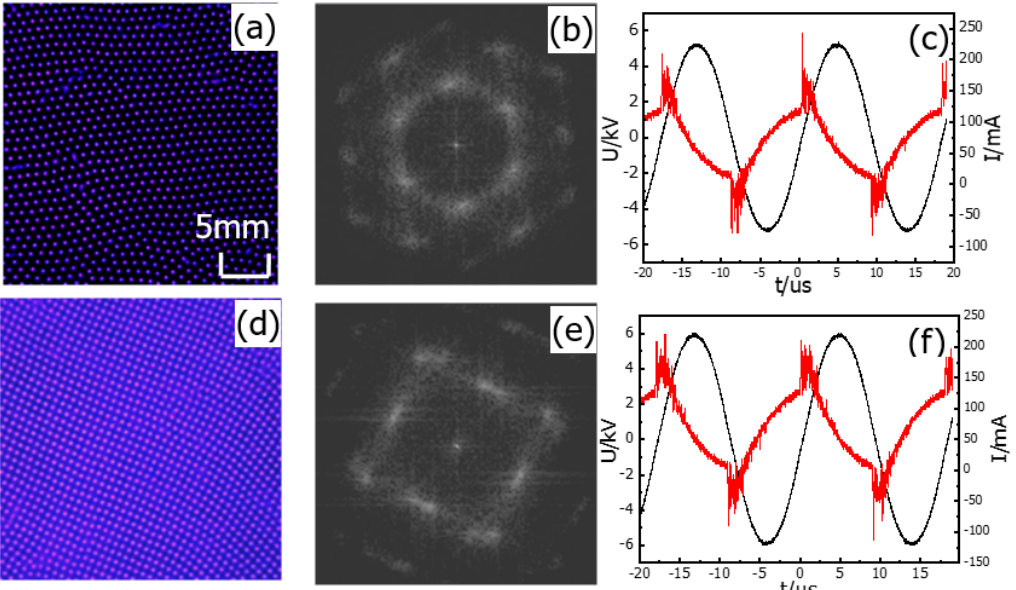
Figure 2. Plasma photonic crystals with different symmetries when increasing of the applied voltage. The left column: snapshots of the triangular plasma photonic crystal ( a ) and square plasma photonic crystal ( d ). The middle column: the corresponding Fourier spectra of triangular lattice ( b ) and square lattice ( e ). Right column: the voltage-current waveforms associated with the triangular lattice ( c ) and square lattice ( f ). The discharge parameters are: ( a ) the applied voltage U = 5.3 kV, discharge power p = 32 W ( d ) U = 6.0 kV, p = 46 W. The frequency of the applied voltage f = 55 kHz. The working gas is 100% air. The distance of the gas gap d = 1.1 mm. Gas pressure p = 300 torr and the exposure time t = 40 ms.